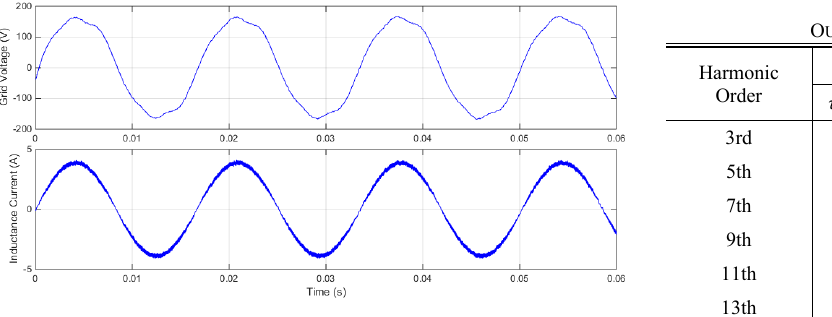
Fig. 10. Output voltage and output current when L g = 19.5 mH ( k p = 3)